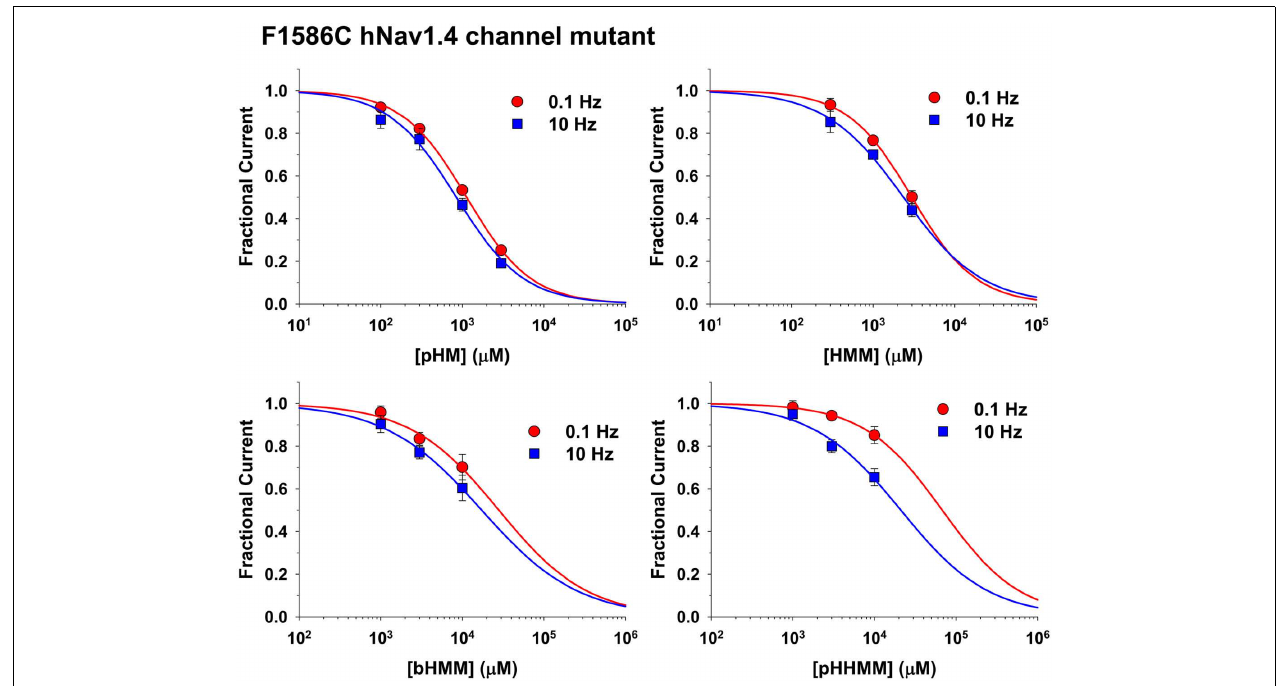
FIGURE 5 | Concentration–response relationships for hydroxylated mexiletine analogs on F1586C hNav1.4 channel mutants. The curves were constructed at 0.1 and 10Hz frequency stimulation, and fitted with a